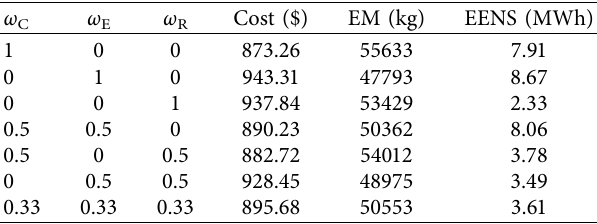
Table 3: The Prato front results for the proposed